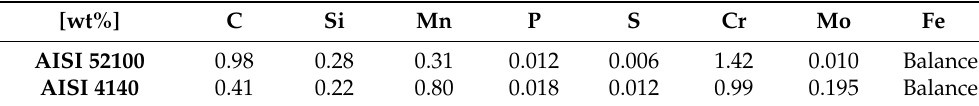
Table 1. Chemical composition of steel alloys AISI 52100 and AISI 4140. [wt%]